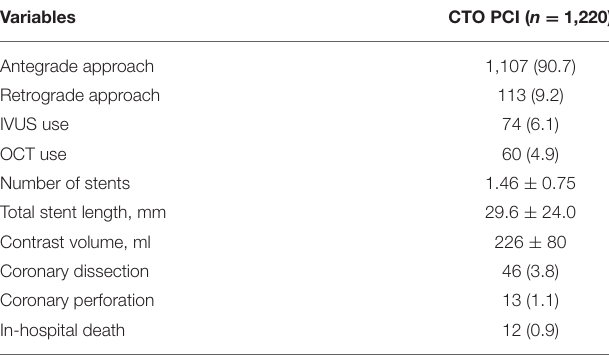
TABLE 2 | Procedural